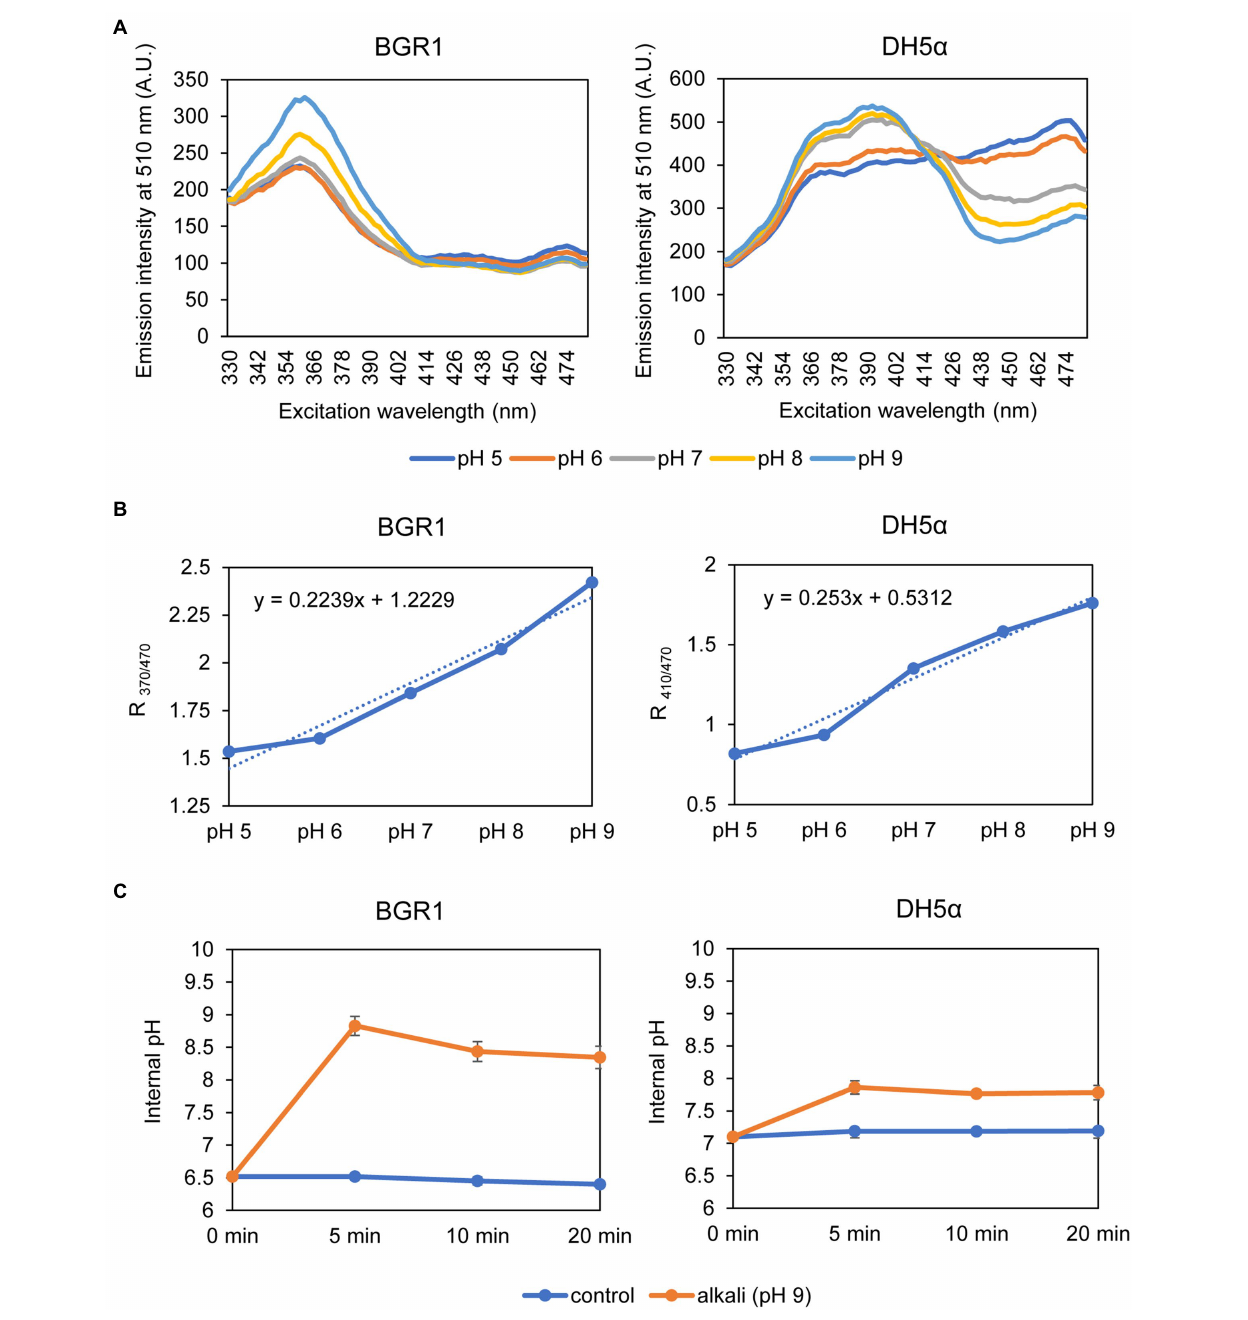
FIGURE 8 | Measurement of the internal pH of wild-type BGR1 and E. coli DH5 α . (A) Fluorescence excitation spectrum of pHluorin for wild-type BGR1 and E. coli DH5 α (330–482 nm; emission, 510 nm). Wild-type BGR1 and E. coli DH5 α were grown in LB broth for 14 h at 37 ° C, and the cells were resuspended in DPBS at different pH (pH 5, 6, 7, 8, or 9) in the presence of 40 mM potassium benzoate and 40 mM methylamine hydrochloride. The fluorescence intensity was measured using a microplate reader, and the mean values obtained from three independent experiments are shown. AU, arbitrary units. (B) Calibration curves for wild-type BGR1 and E. coli DH5 α for measuring internal pH. The data for the calibration curves were obtained as the ratios between the excitation peak (R 370/470 or R 410/470 ), and the curves were used to determine the internal pH. (C) Changes in internal pH values after exposure to alkaline stress at pH 9 in DPBS in wild-type BGR1 and E. coli DH5 α . Data are mean ± SE of triplicate